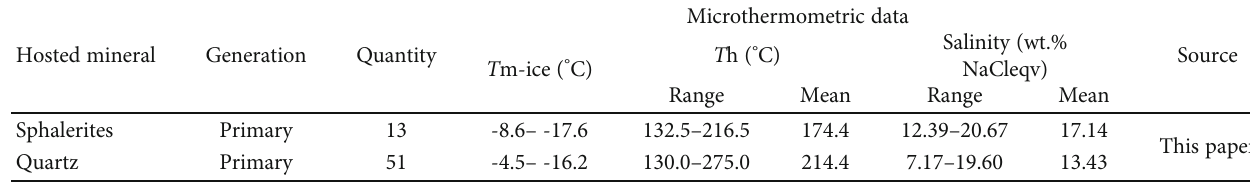
Table 2: Microthermometric data of the fl uid inclusions from the Laoyingqing Pb – Zn deposit. Hosted mineral